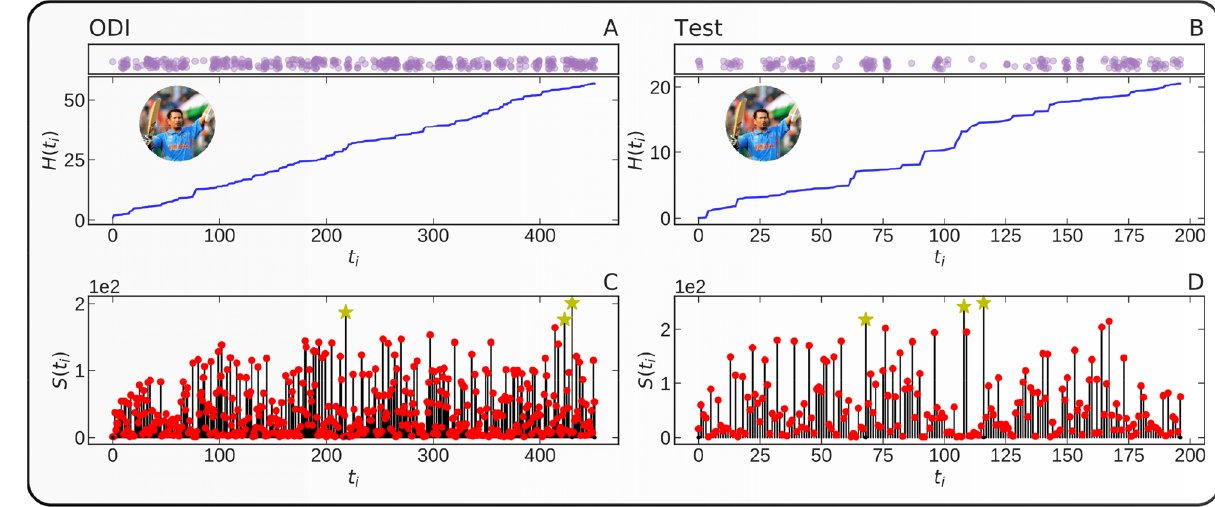
Figure 3. Sequence of performances in the individual career of Sachin Tendulkar. ( A ) Performance time H ( t ) as a function of t , as defined in Eq. (4), for the highest performer in ODI cricket. ( B ) Performance time H(t) for the highest run scorer in Test cricket. ( C ) The performance score S ( t ) of the player in ODI corresponding to panel ( A ). ( D ) The performance score S ( t ) of the player in Test cricket corresponding to panel ( B ). The large yellow stars represent the top 3 performances. The top insets in ( A , B ) give the point process representation of H ( t ) , in which each dot corresponds to an instant of time along the H ( t ) time axis. We have added noise along the y-direction for better